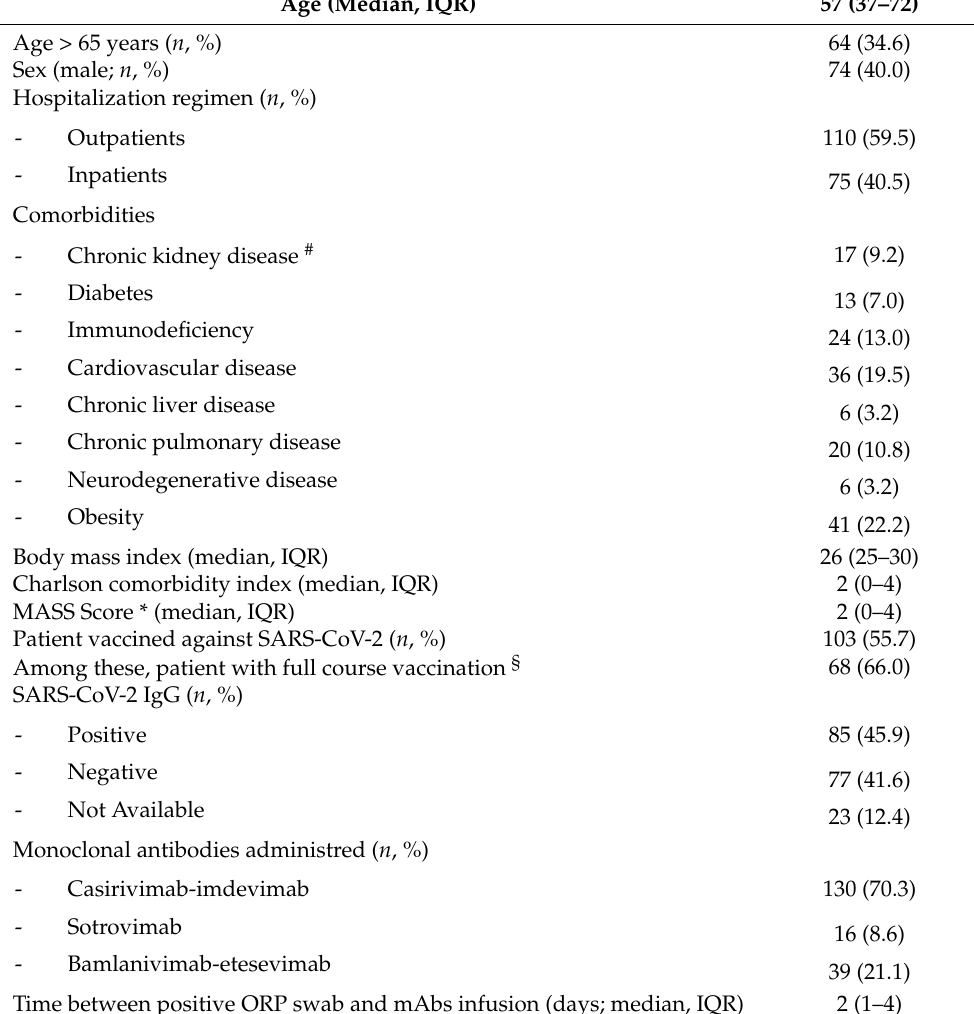
Table 1. Demographic and clinical characteristics of the enrolled patients ( n =